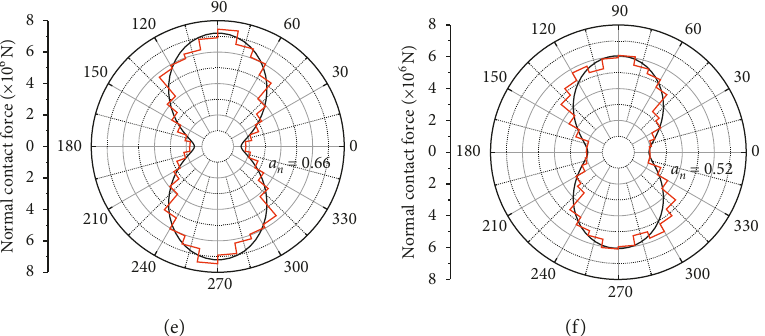
Figure 10: Evolution of anisotropy in normal forces during shearing: (a) ε ε a � 16%.